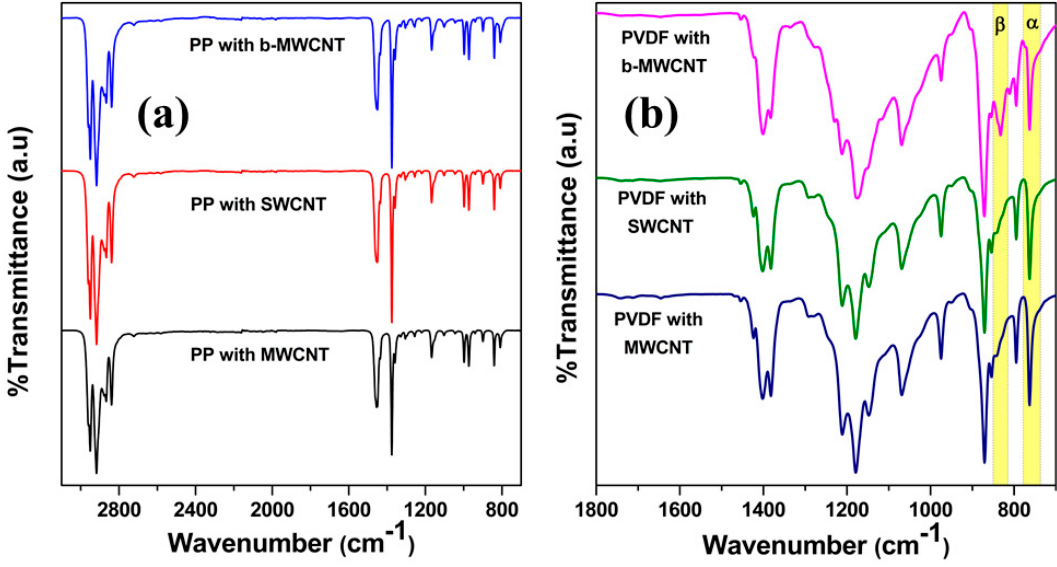
Figure 7. FT-IR spectra of PP based composites ( a ) and PVDF based composites ( b ) All composites contain 2 wt % CNT.